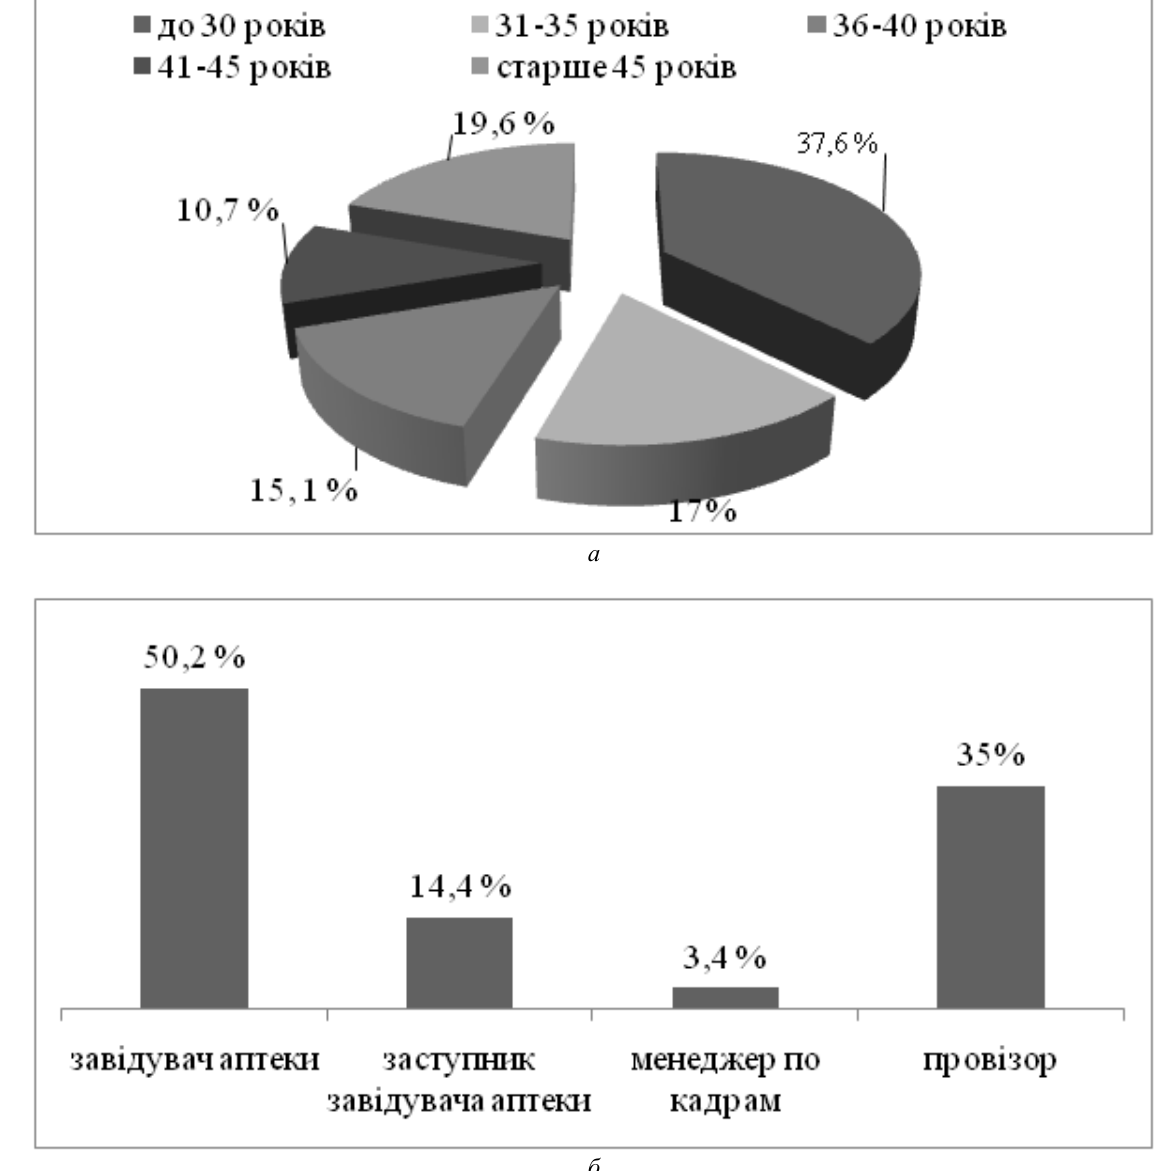
Рис. 1. Розподіл респондентів за: а – віком; б –